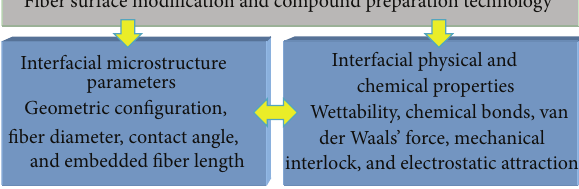
Figure 2: Interface optimization ways.